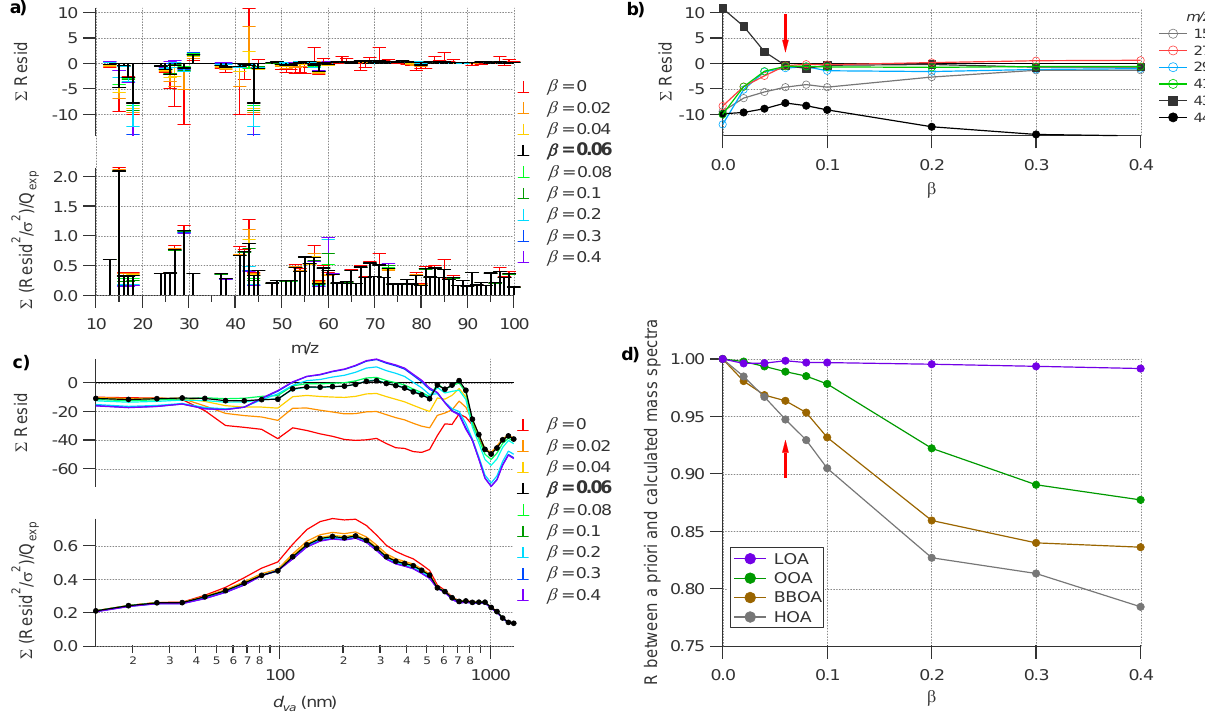
Fig. 6. Residuals and Q/Q exp values for solutions of the constrained vector-matrix model with four factors. (a) Total residual (top panel) and Q/Q exp contribution (bottom panel) from each m/z . (b) Total residual for selected m/z ’s as the solution is relaxed with increasing β . (c) Total residual (top panl) and Q/Q exp contribution (bottom panel) at each particle size. (d) Correlation between the a priori and calculated mass spectra as the constraint is relaxed with increasing β . The solution selected as “best” has β =0.06 – black lines in (a) and (c) and red arrows in (b) and (d)